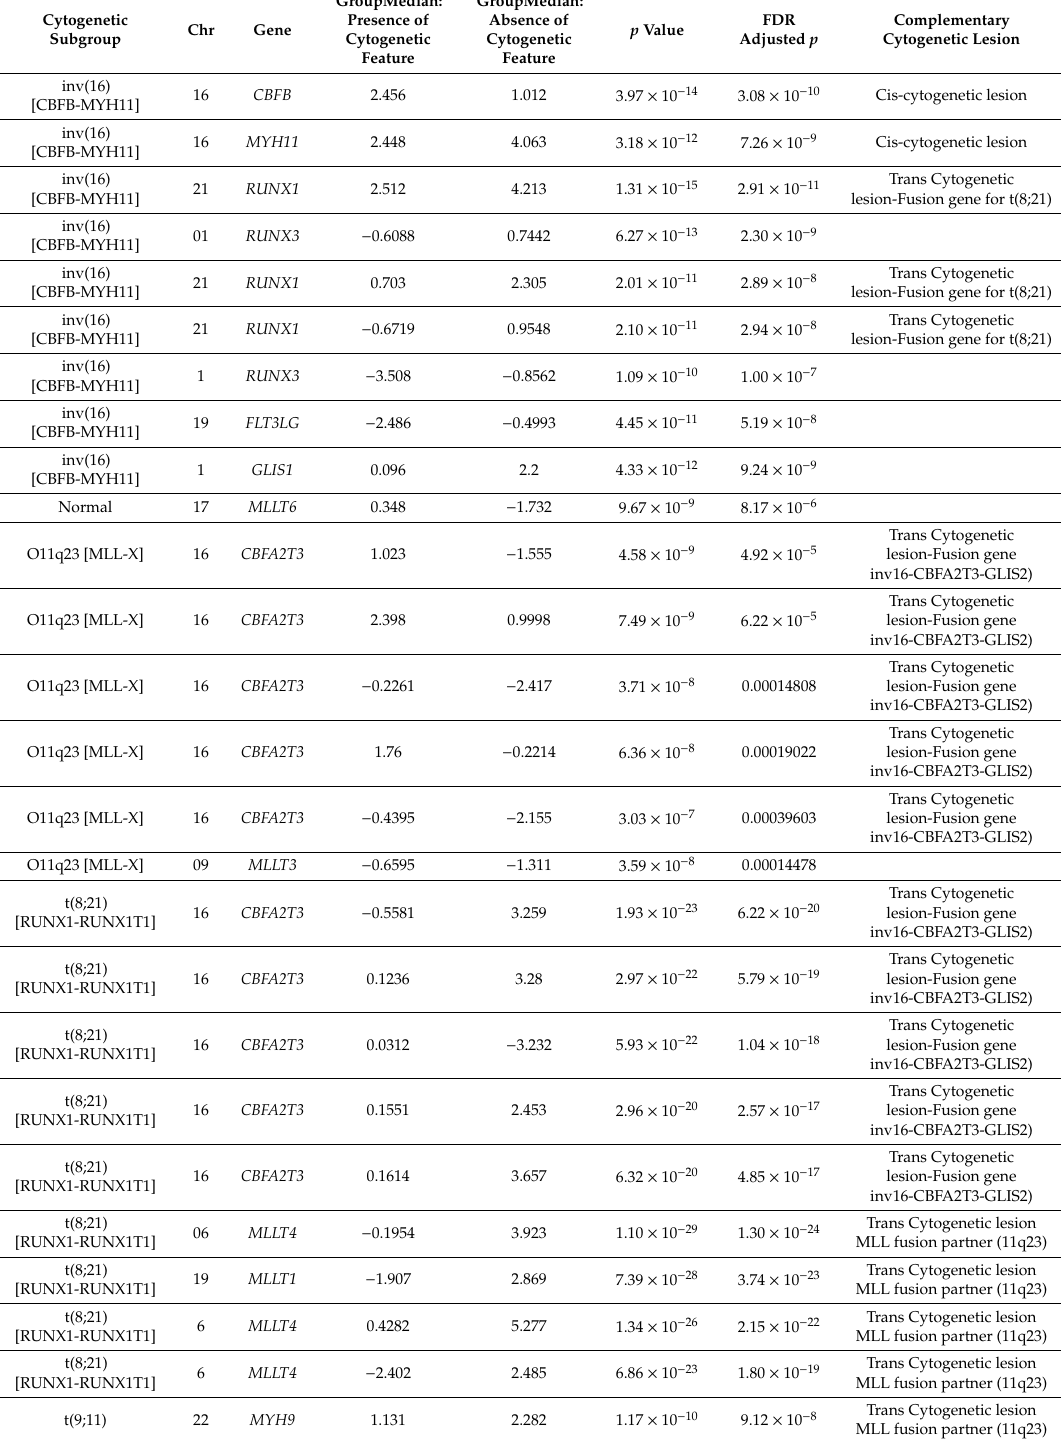
Table 3. Complementary methylation deregulation of AML hot spot genomic regions by cytogenetic characteristics. Cytogenetic Subgroup Chr